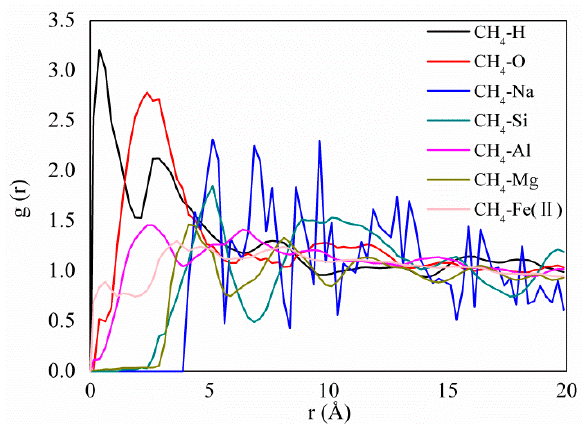
Figure 6. RDFs between the CH 4 and different atoms of pure and doped kaolinite.